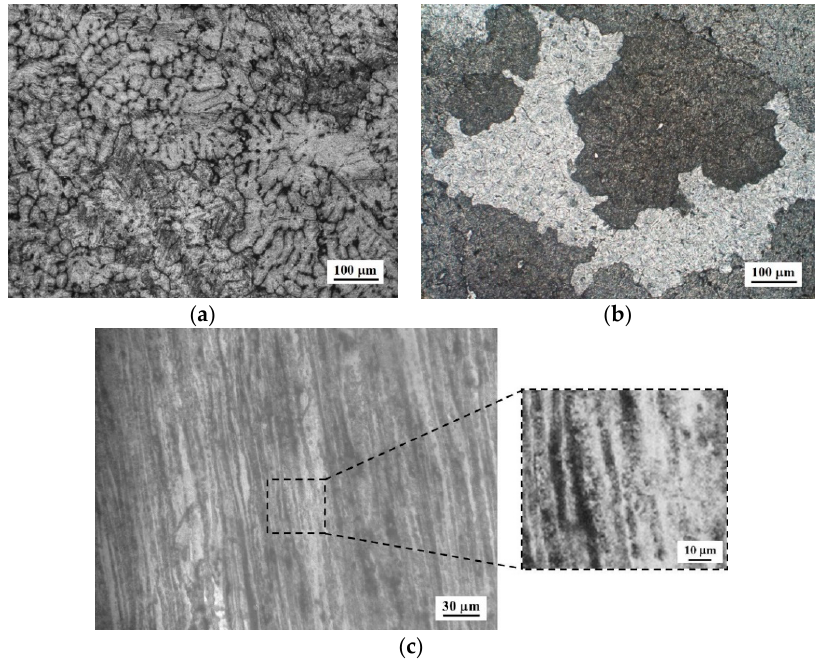
Figure 1. Optical initial microstructure of AZ31-2Ca alloy for different conditions: ( a ) As-cast; ( b ) homogenized; and ( c ) disintegrated melt deposition (DMD) processed-extrusion direction is vertical.